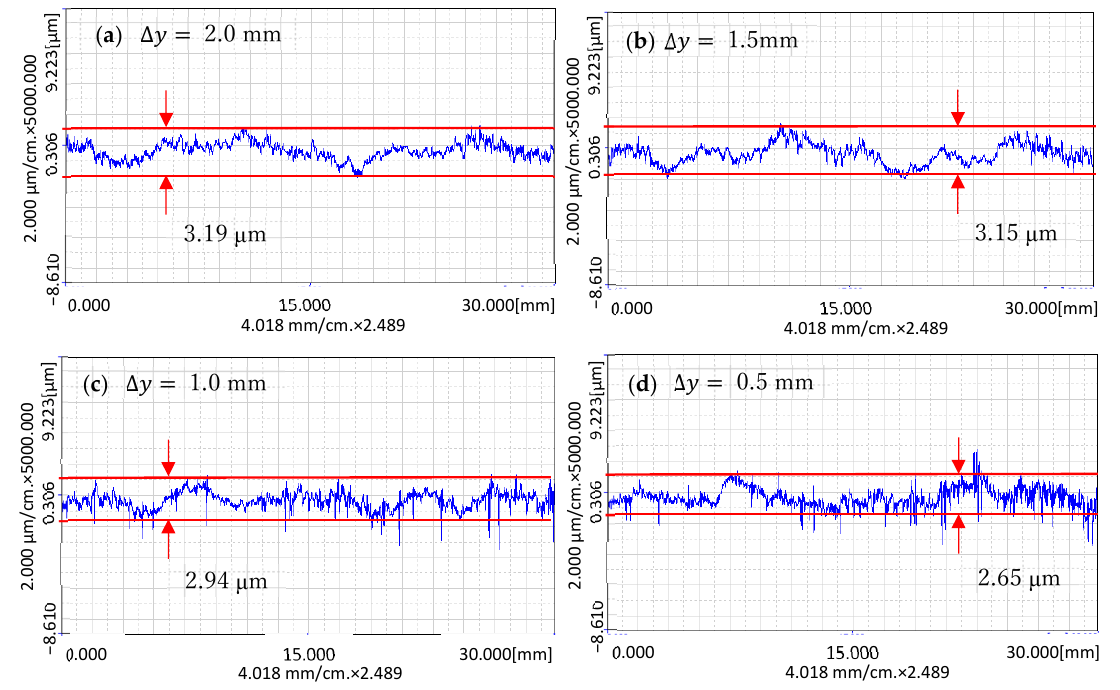
Figure 17. The cross-section curves of the surface along the x -direction after processing: ( a ) The cross-section curves at ∆ y = 2.0 mm; ( b ) The cross-section curves at ∆ y = 1.5 mm; ( c ) The cross-section curves at ∆ y = 1.0 mm; ( d ) The cross-section curves at ∆ y = 0.5 mm.